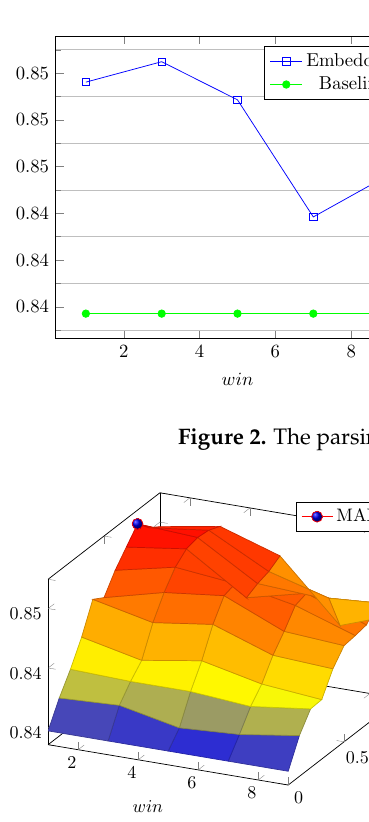
Figure 3. The fusion parsing accuracy under different win and η